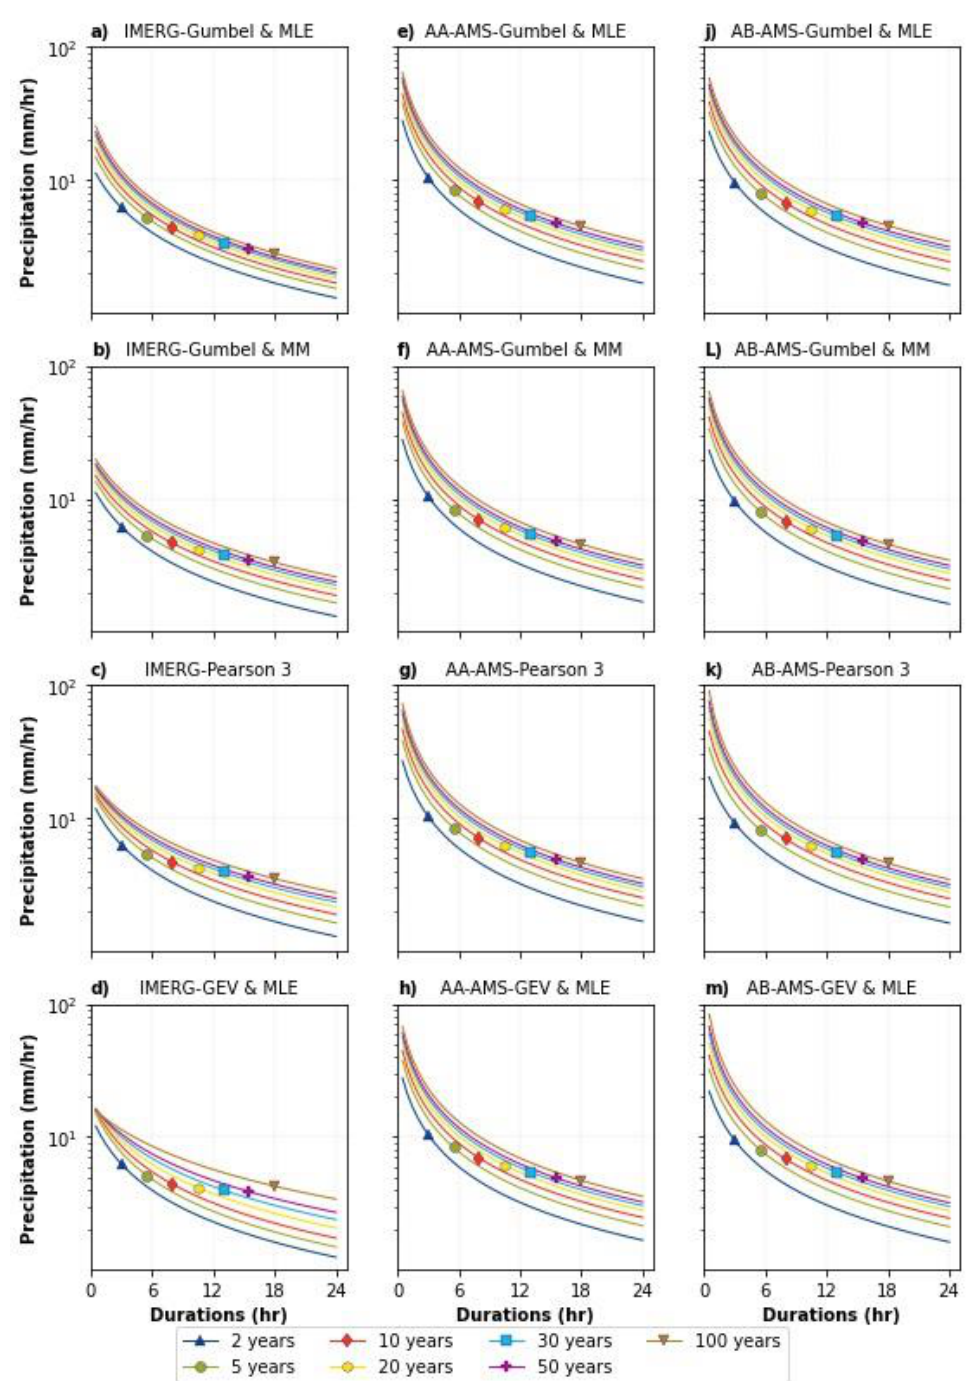
Figure A9. IDF curves fitted with the four CDFs over WGEW 2 for the 2, 5, 10, 20, 30, 50, and 100 year return periods and durations from half-hour to 24 h. From left to right : IMERG, AA-AMS, and AB-AMS. From top to bottom : Gumbel and MLE, Gumbel and MM, Pearson 3, and GEV and MLE The marker’s purpose is only to distinguish the IDF curves.